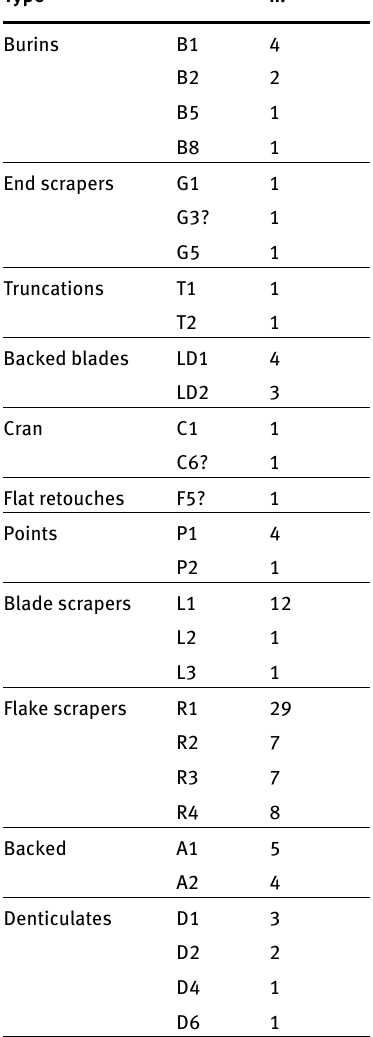
Table 2. Obsidian tools at San Vincenzo according Laplace